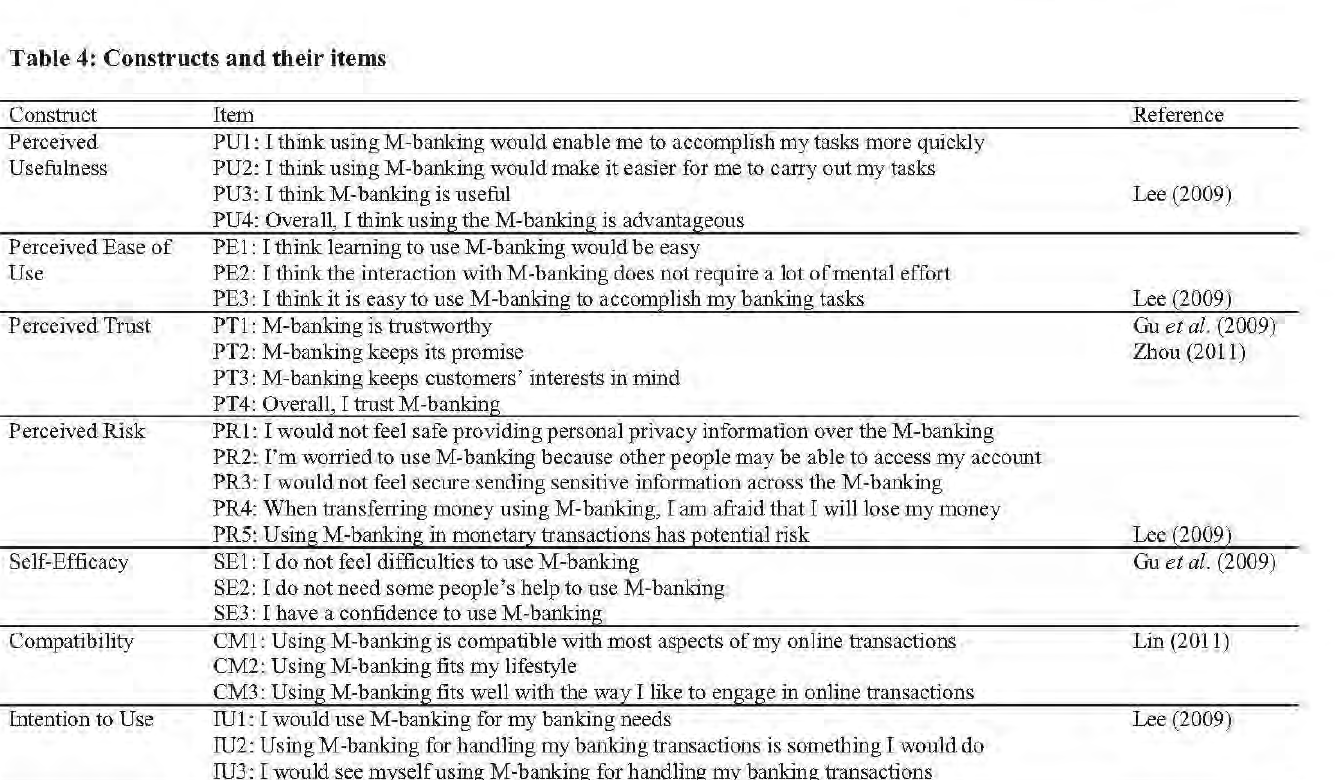
Table 4: Constructs and their items Construct Perceived